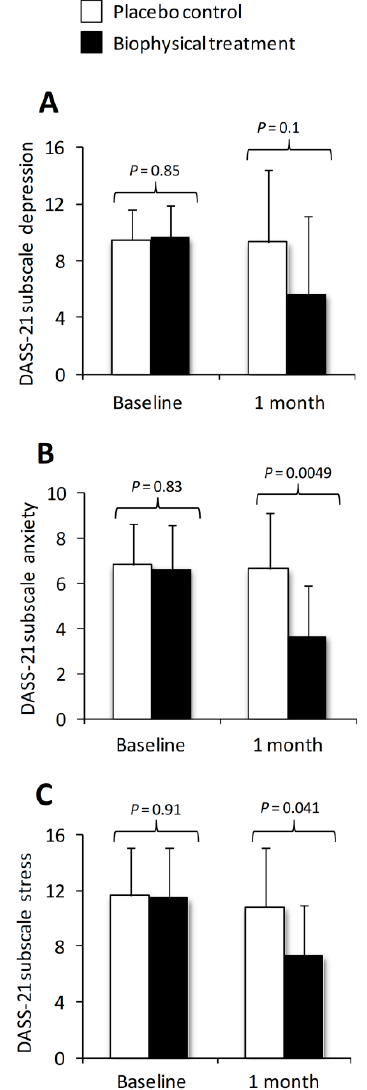
Figure 2. Effect of biophysical therapy and placebo control on DASS-21 subscales. The three subscales include depression ( A ), anxiety ( B ) and stress ( C ). Data are presented as mean ± SD and p -values denote statistical significance between groups.